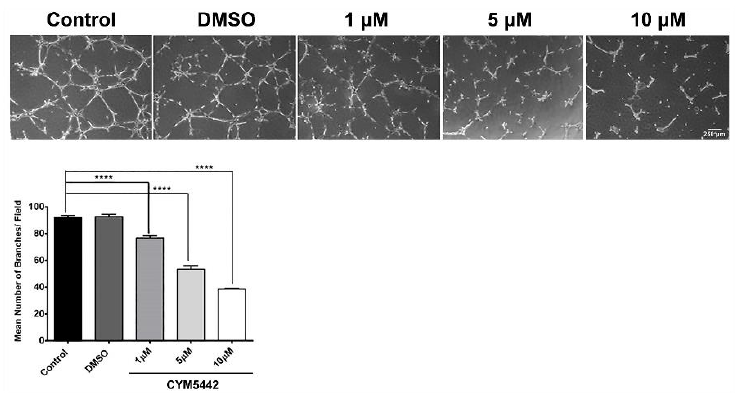
Figure 7. The S1PR1 agonist CYM5442 inhibits ChEC capillary morphogenesis. ChECs were detached and incubated with varying concentrations of CYM5442 (in DMSO) or DMSO on ice for 20 min. Incubated cells were then applied to Matrigel-coated plates, incubated, and photographed after 14 h as described in Methods. The mean number of branch points was determined. **** p < 0.0001. ( n = 3).